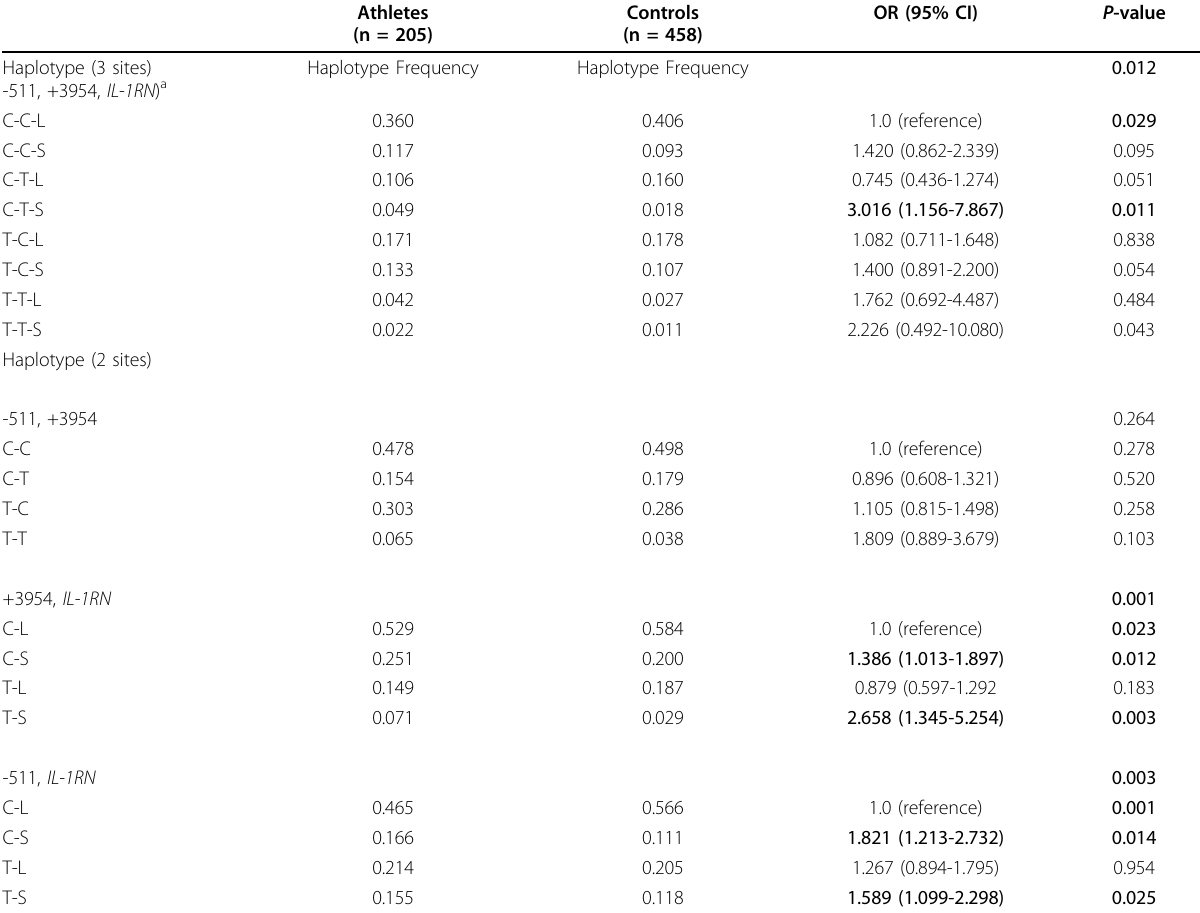
Table 6 Haplotype frequencies in athletes and non-athlete